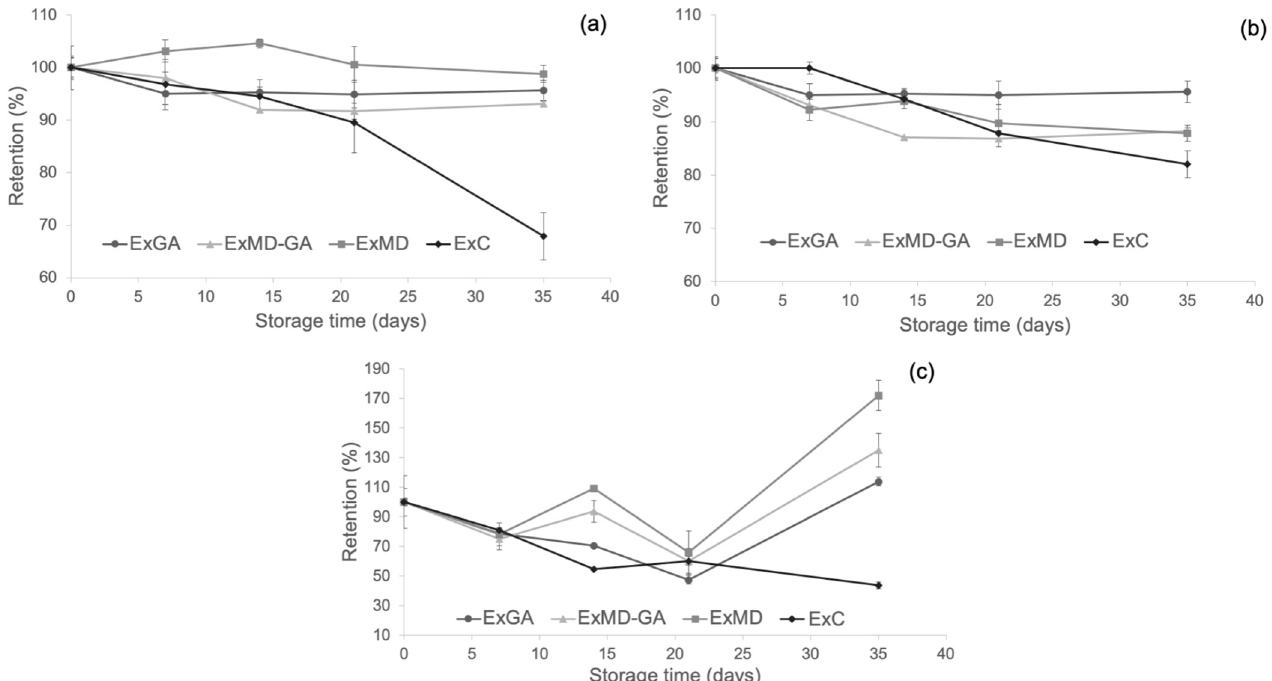
Figure 7. Changes of ( a ) TPC; ( b ) FRAP antioxidant activity; ( c ) ABTS antioxidant activity of the microencapsulates and the concentrated hop extract at 50 °C during storage. Data are expressed in retention percentage with respect to the initial value of the non-stored samples.